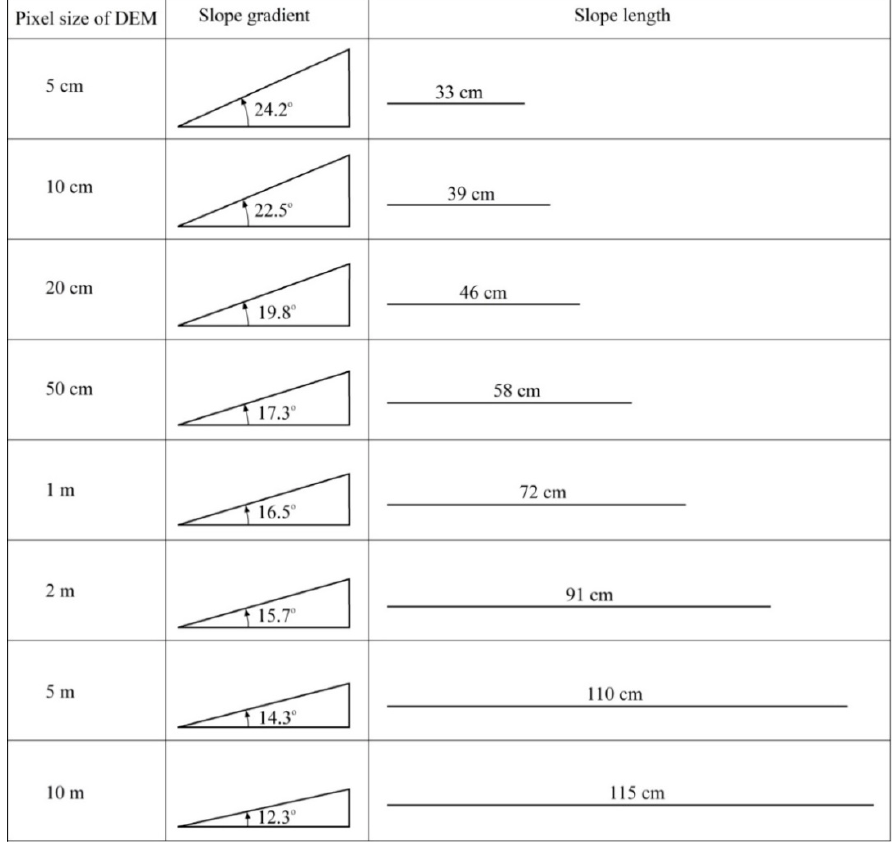
Figure 5. LS factor ( a , b ) and rate of soil erosion (t/h/y) ( c , d ) by pixel sizes of DEM.